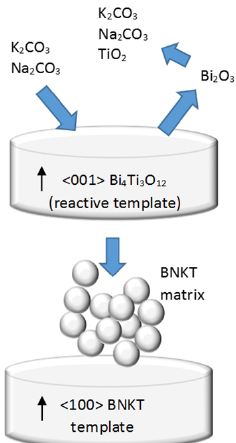
Figure 11. Schematic representation for the formation of BNKT templates from BIT particles and complementary reactants.